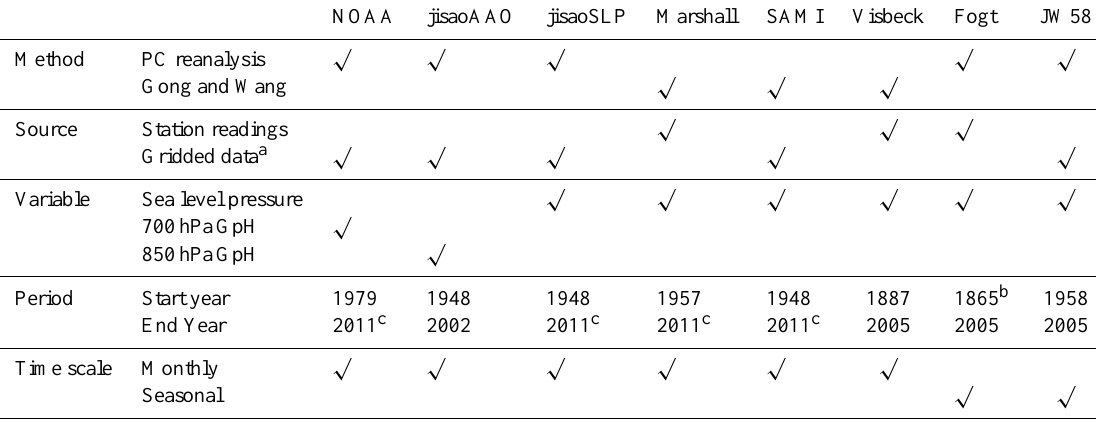
Table 1. Summary of SAM index development methods and periods of